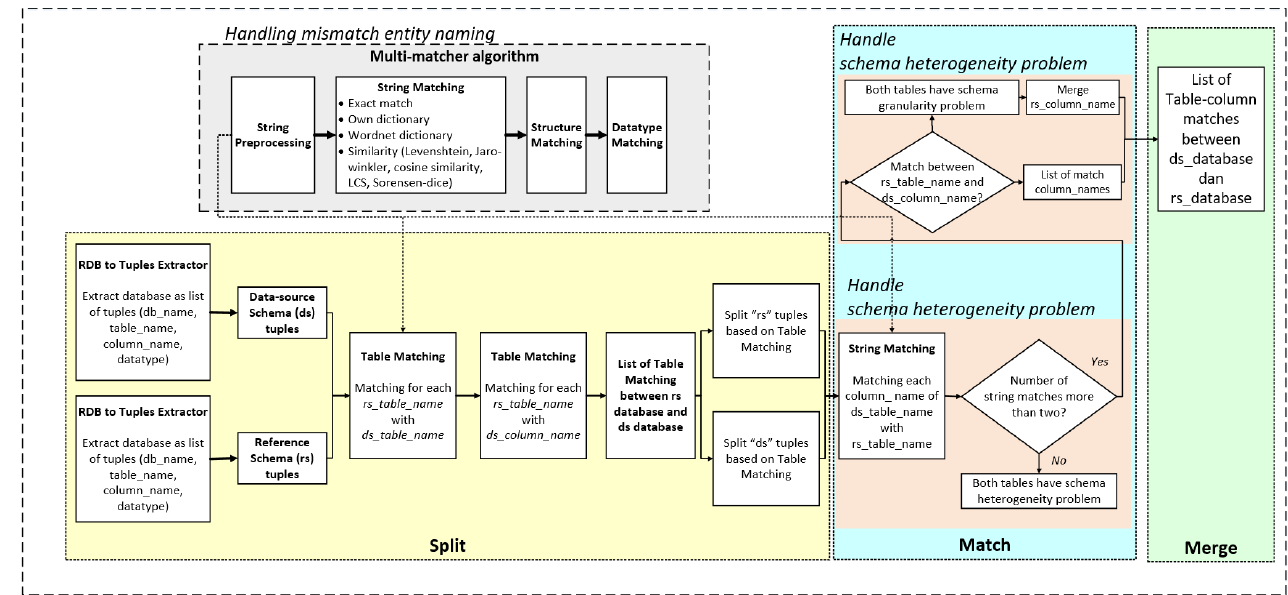
Figure 6. The details of the split, match and merge method with a multi-matcher algorithm.